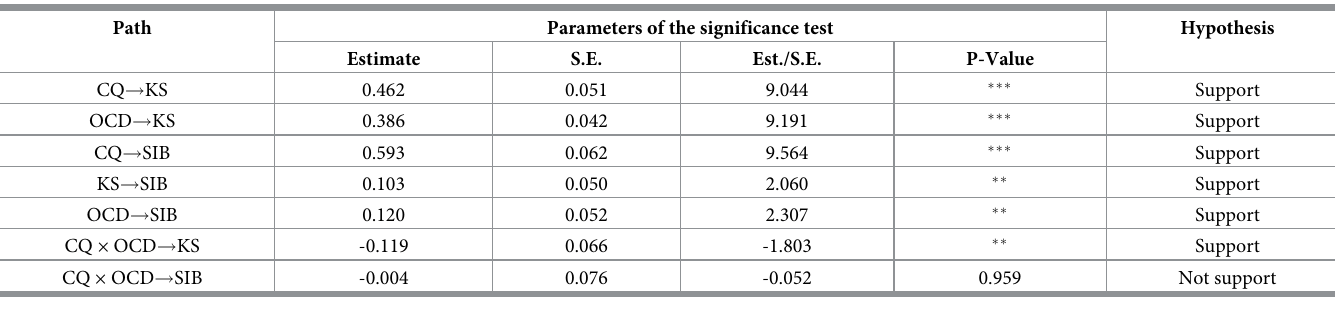
Table 5. SEM path analysis.